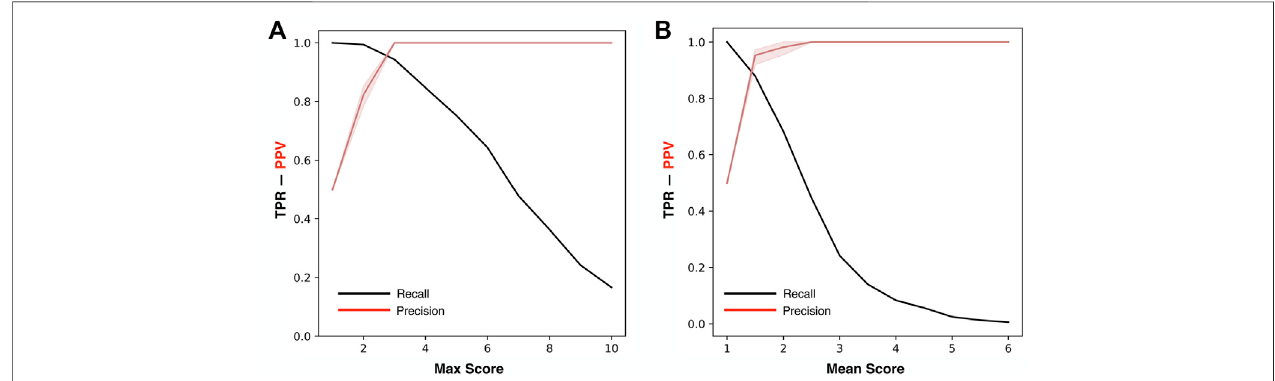
FIGURE1| PrecisionandRecallofThermoScanatdifferentclassi fi cationthresholds.TheplotsshowtheperformancebasedontheMax (A) and Mean (B) scores. The performance measures TPR (black) and PPV (red) are de fi ned in Supplementary Materials . The shaded area represents the range between the minimum and maximum scoring